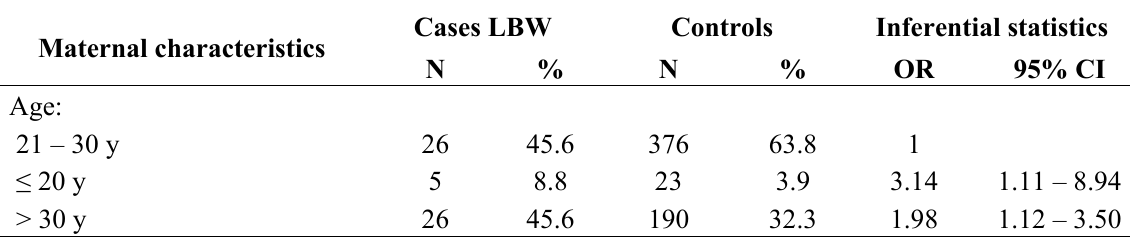
Table 2. Distribution of maternal characteristics among low birth weight (LBW) cases and controls, odds ratios (OR) and their 95% confidence intervals